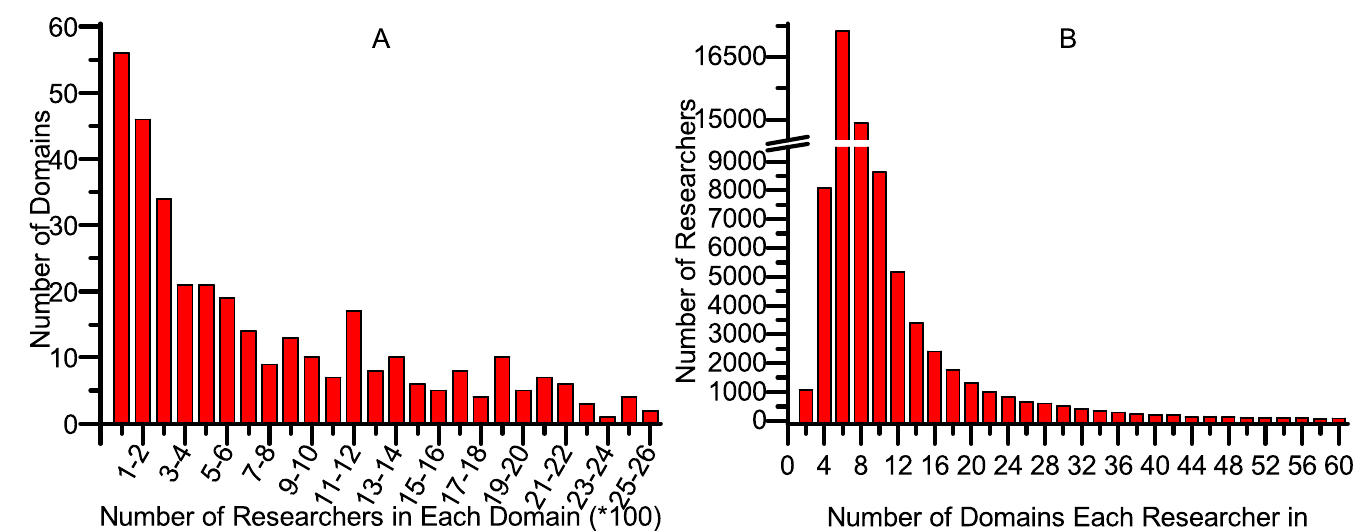
Fig 5. Statistics of data after topic clustering and researcher